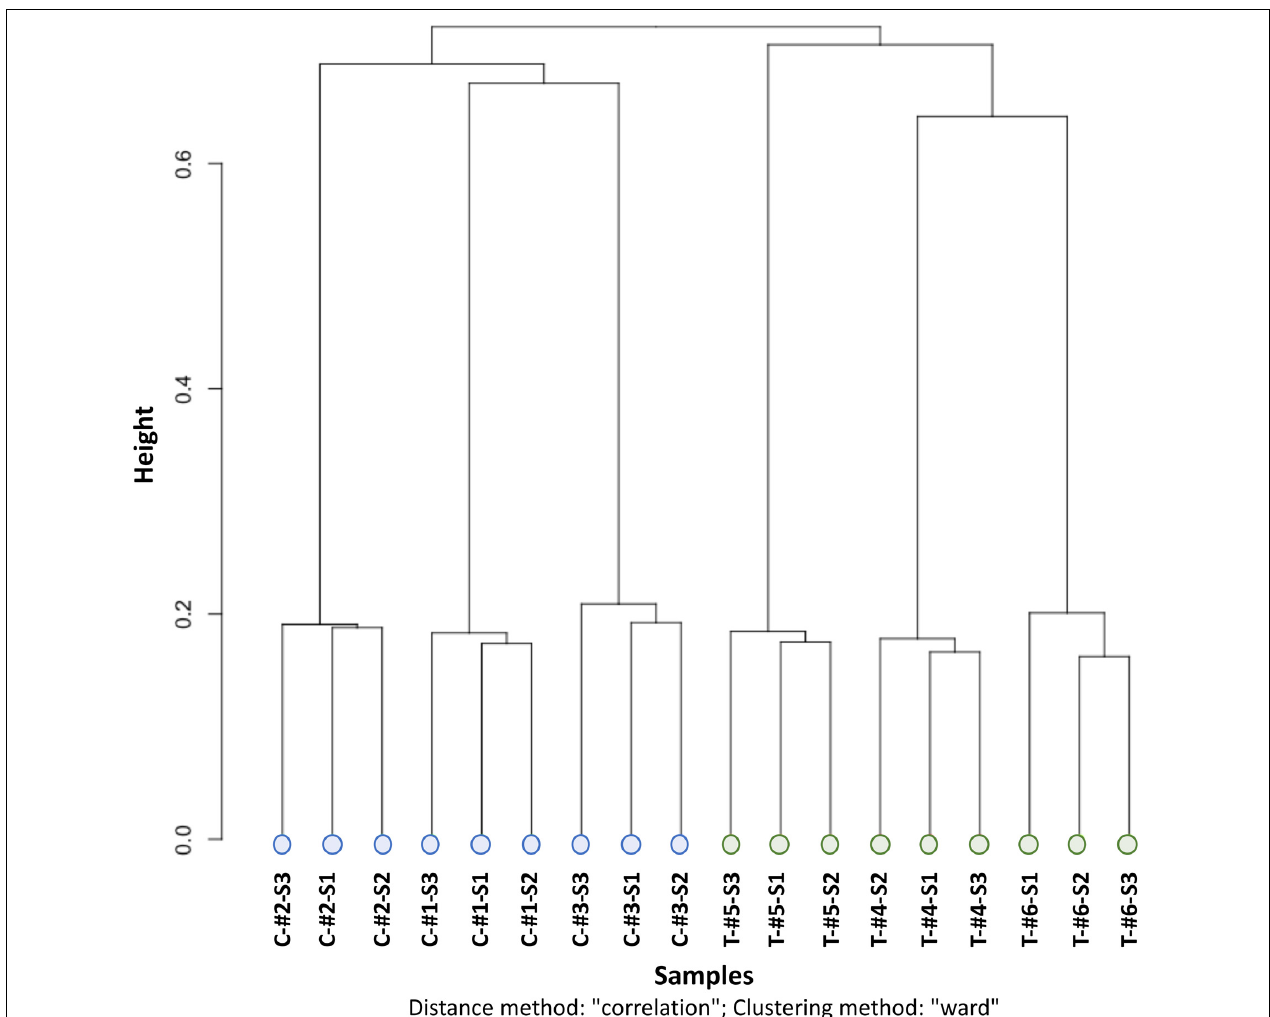
FIGURE 3 | CpG methylation clustering with the distance method “correlation” and clustering method “ward” from the clusterSamples function of the R package Methylkit . C, control individual (in blue); T, depth treatment individual (in green); #, label of the individual number; S1, sampling time 1; S2, sampling time 2; S3, sampling time